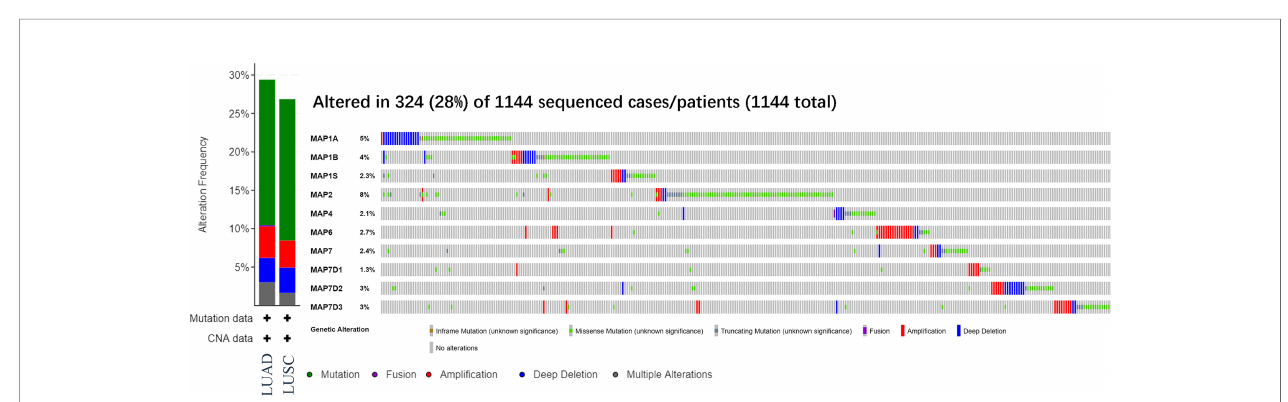
FIGURE 6 | MAP gene alterations analysis in LUAD and LUSC (cBioPortal). LUAD, lung adenocarcinoma; LUSC, lung squamous cell carcinoma; MAP, microtubule-associated